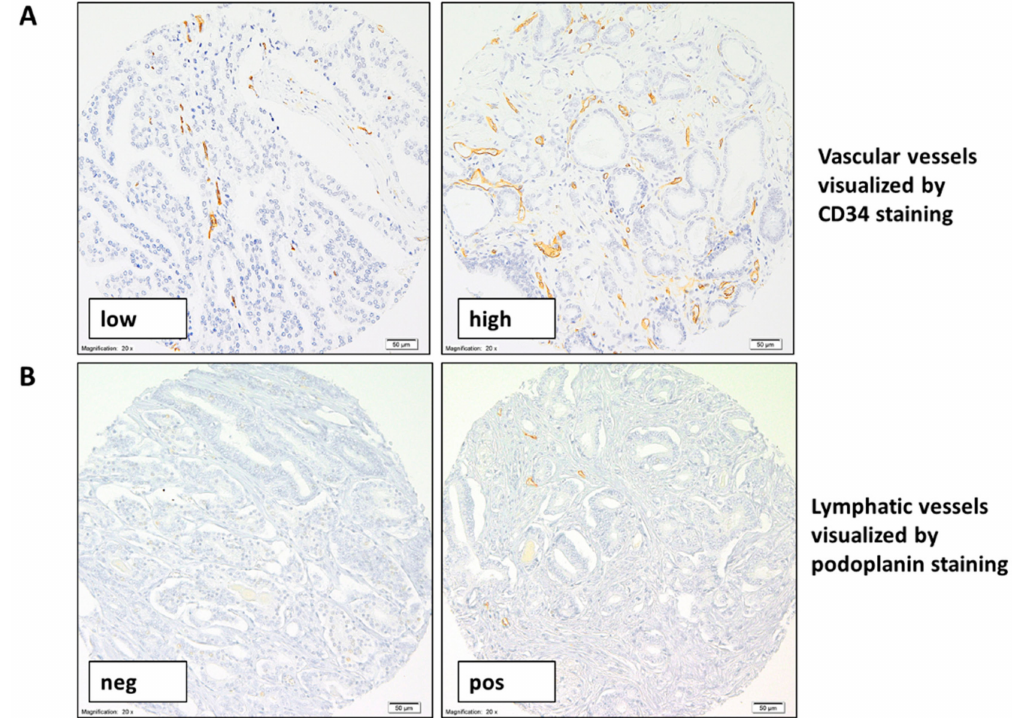
Figure 1. Representative pictures of CD34 and podoplanin staining in prostate cancer (PCa). Representative pictures of CD34 ( A ) and podoplanin ( B ) immunohistochemical staining